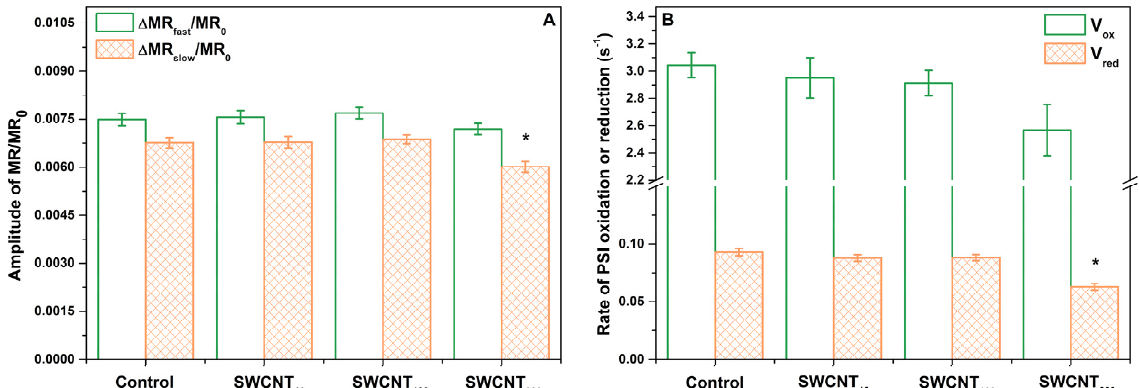
Figure 5. Relative amplitudes of initial decrease ( Δ MR fast ) and subsequent rise ( Δ MR slow ) of the MR signal ( A ) and rates of P 700 oxidation and re-reduction ( B ). Asterisks indicate statistically significant differences to the respective control revealed with ANOVA and Holm-Sidak ad hoc test at α = 0.05.